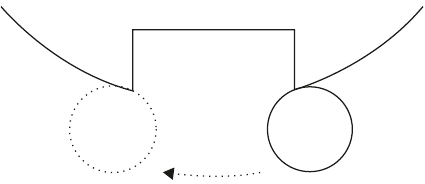
Figure 1: Physical model